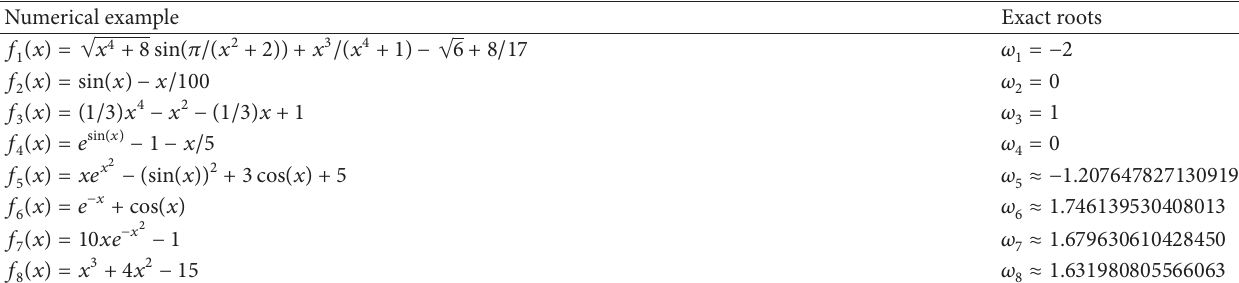
Table 1: Test functions and exact